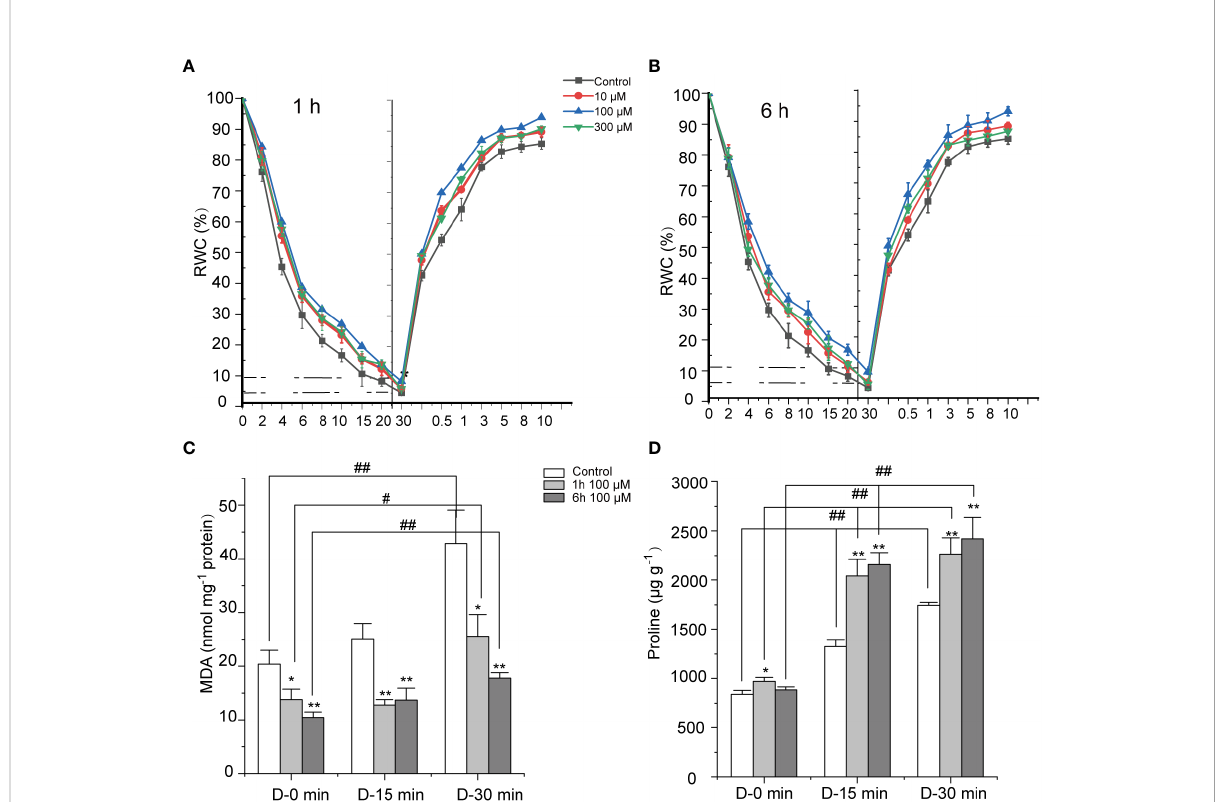
FIGURE 1 Effects of abscisic acid (ABA) on the dehydration tolerance of Neoporphyra haitanensis. (A, B) Effect of ABA on the relative water content (RWC) of N. haitanensis during the dehydration – rehydration cycle process. The thalli were pre-treated with different concentrations of ABA for 1 or 6 hours, before being exposed to air for 30 minutes to allow for drying, following rehydration in sterile seawater for 10 minutes. The RWC of thalli samples were measured at each time point (n = 5). The statistical signi fi cance is shown in Supplementary Table 2. (C, D) Effects of ABA on malondialdehyde (MDA) and proline contents in N. haitanensis during dehydration. The thalli were pre-treated with 100 m M of ABA for 1 or 6 hours, then exposed to air for 15 or 30 minutes to allow for drying. The MDA and proline contents were determined. * P < 0.05, ** P < 0.01, compared to the Control group, # P < 0.05, ## P < 0.01, compared to the same treatment group with different drying periods, n =